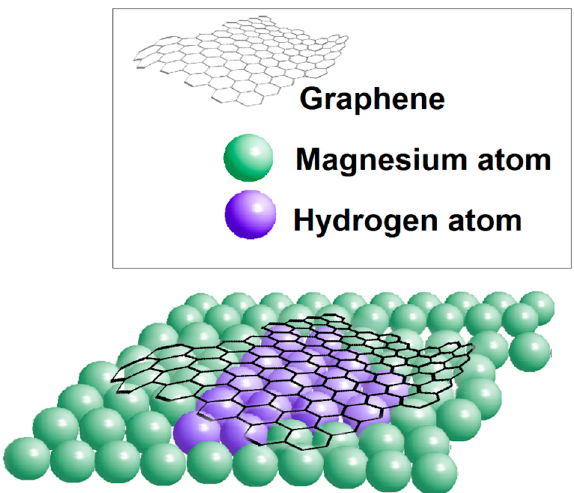
Figure 14. Schematic illustration of the inhibition of hydrogen gas release via the atomic-scale barrier of a graphene sheet on the in vivo degradation of Mg-based implants, reproduced from [47], with permission from Wiley, 2019.